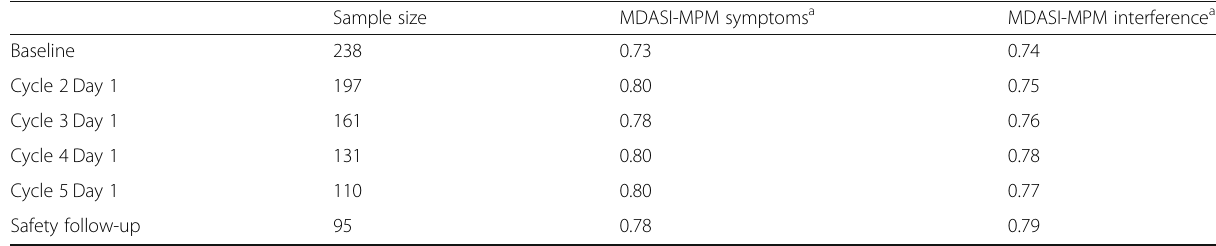
Table 3 Concurrent validity by correlation of MDASI-MPM subscale scores with LCSS-Meso score at various timepoints Sample